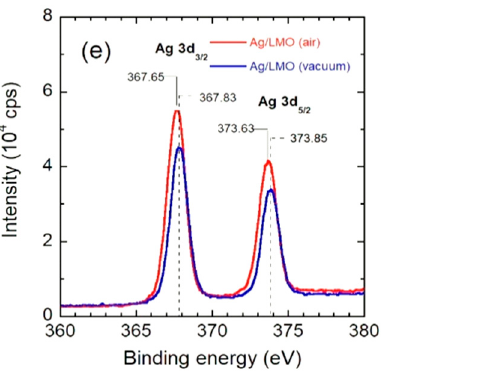
Figure 6. ( a ) XPS survey spectra. High-resolution XPS spectrum of Mn 2p core level of: ( b ) pristine LMO; ( c ) Ag / LMO(a); and ( d ) Ag / LMO(v). ( e ) High-resolution XPS spectrum of Ag 3d core level of Ag / LMO (a) and Ag / LMO (v) samples.